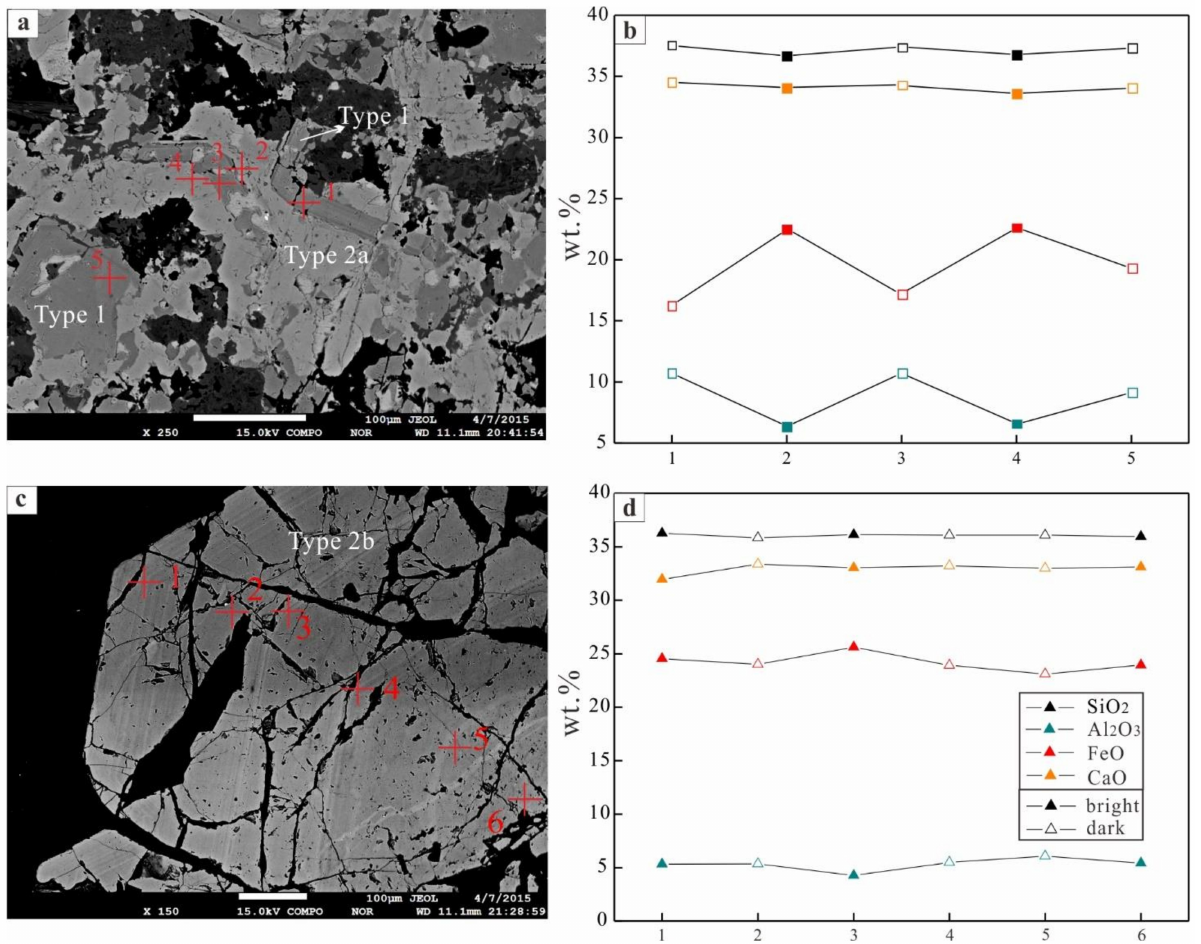
Figure 8. Back-scattered scanning electron microscope images ( a , c ) and major elements compositional variations ( b , d ) for Type 1 and Type 2 garnet